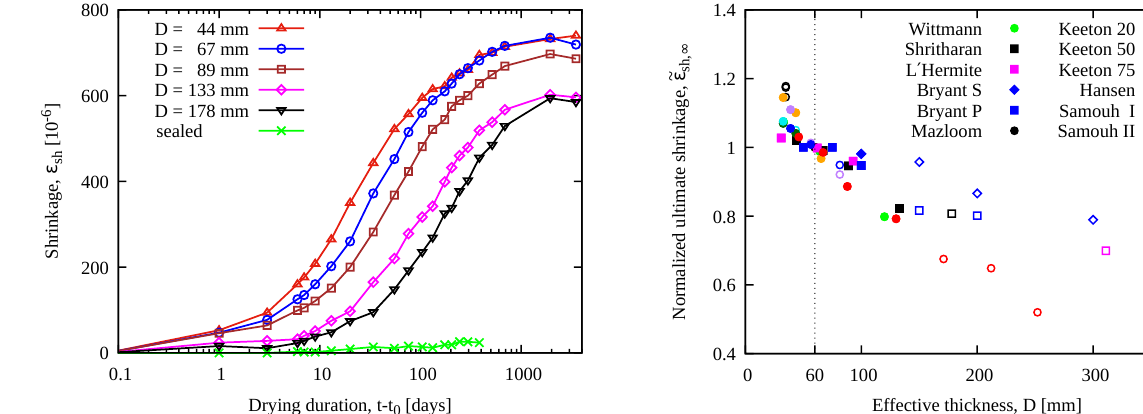
Figure 3. Evolution of drying shrinkage measured by Shritharan, the data adapted from [16] serve as an example of experiment in which the shrinkage of all specimens can be considered to have terminated.